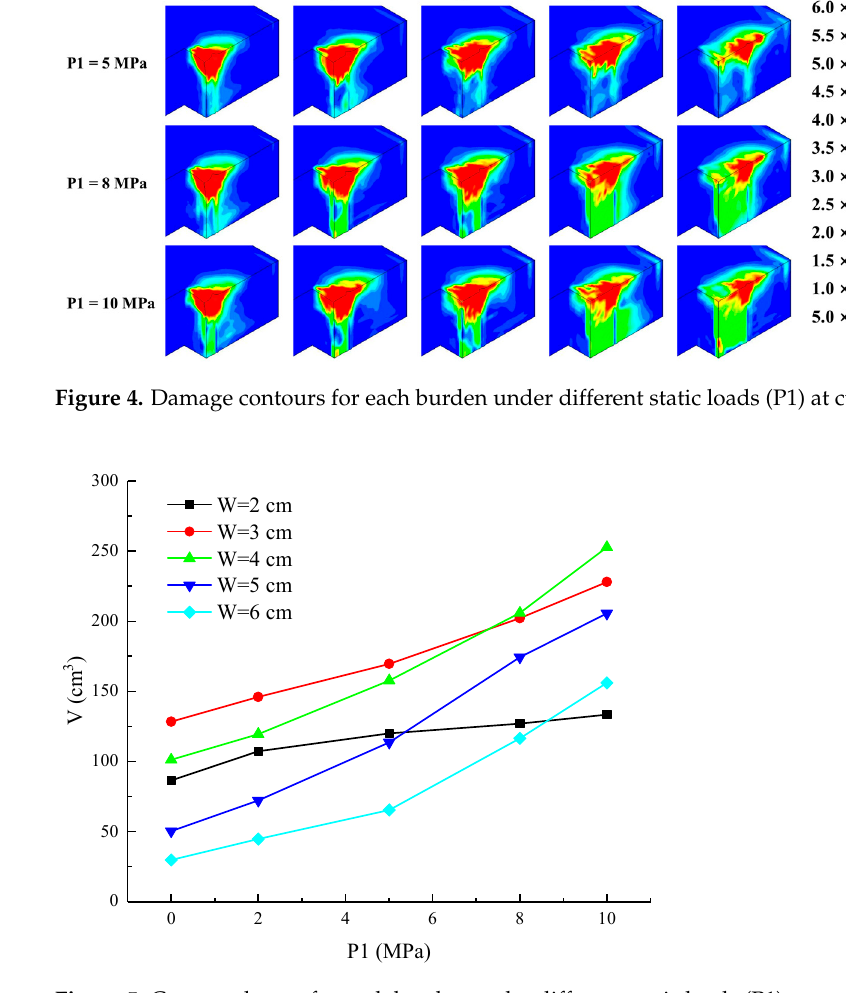
Figure 5. Crater volumes for each burden under different static loads (P1).